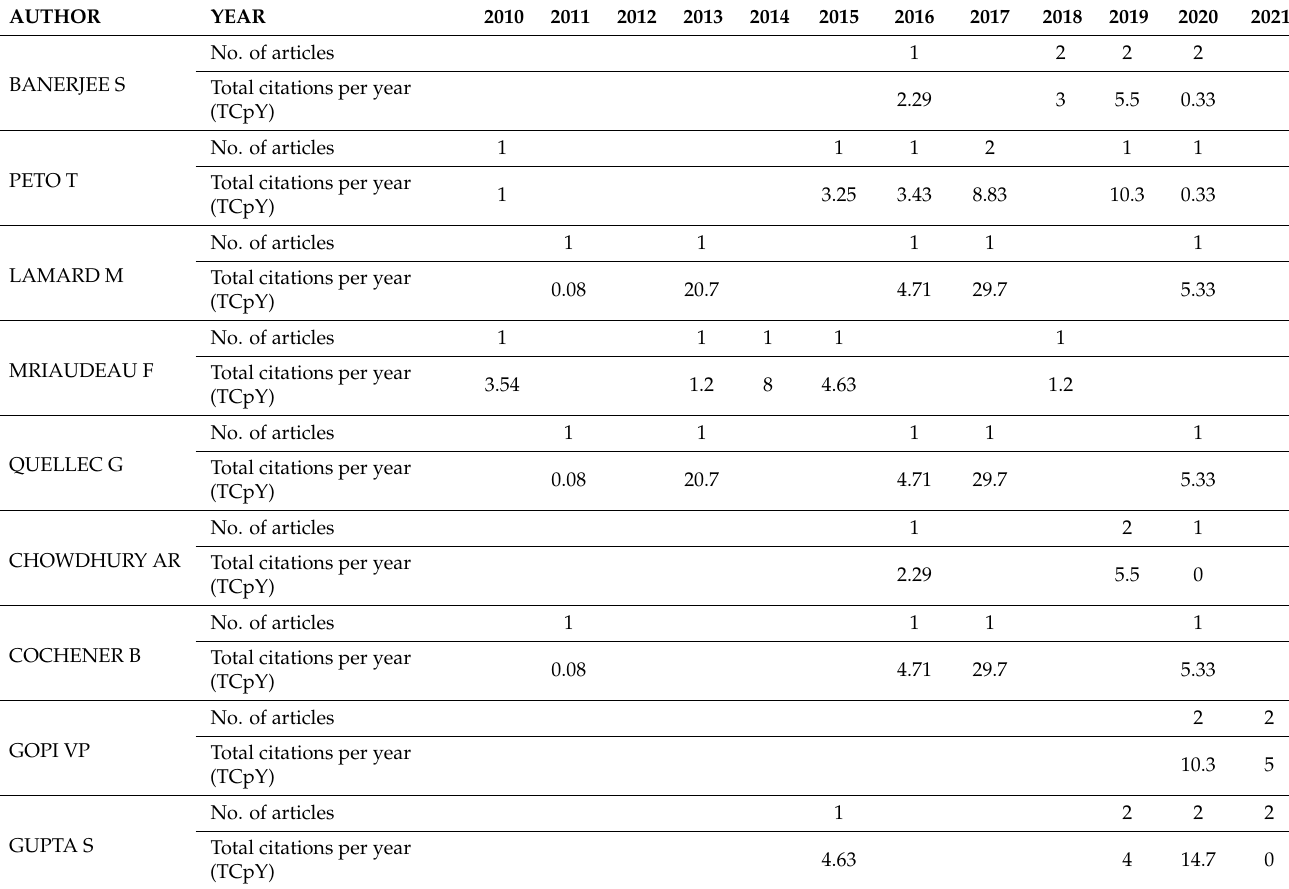
Table 3. No. of articles and total citations per year for the top